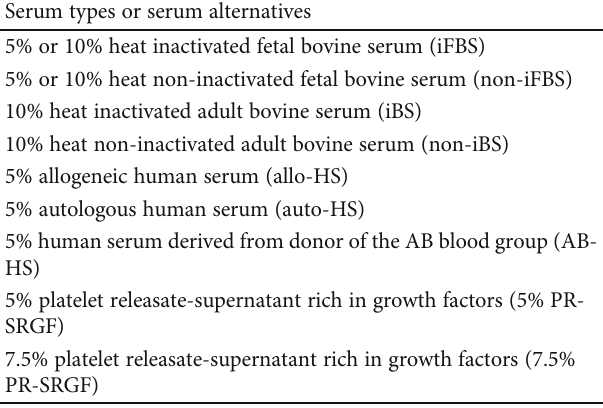
Table 1: Tested serum types or serum alternatives and their